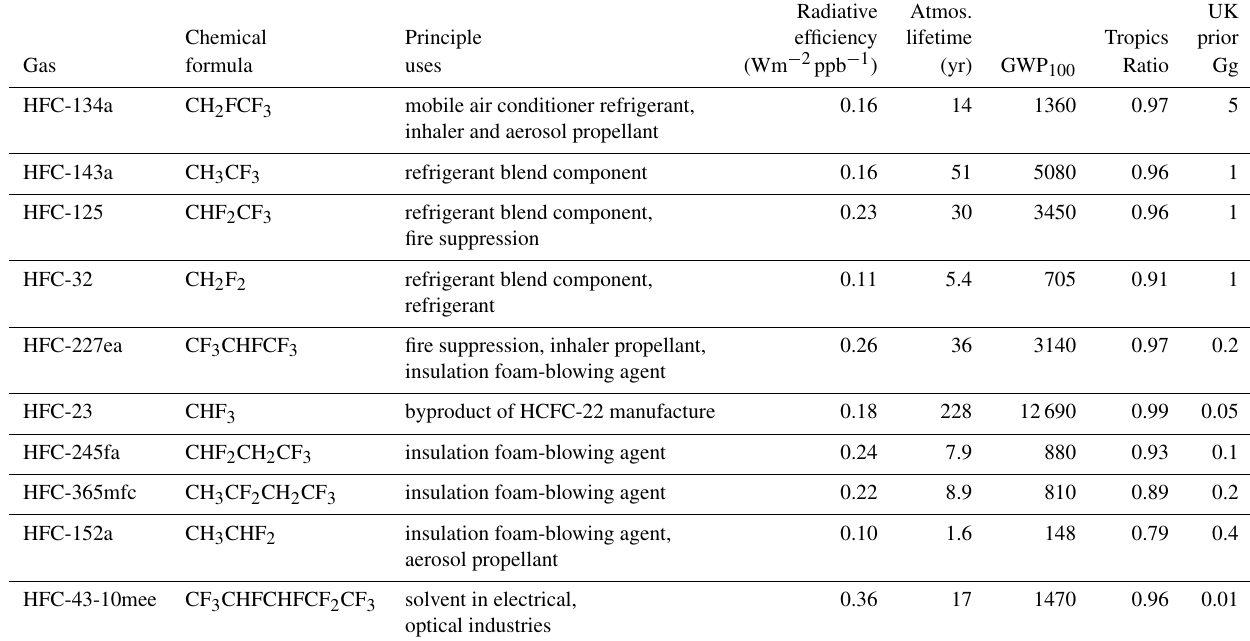
Table 4. Principle uses of each of the HFCs, their radiative efficiency, atmospheric lifetime, global warming potential in a 100-year framework (GWP 100 ) (Montzka et al., 2018b), average ratio of mole fraction between the northern tropics (RPB, Barbados) and the northern mid- latitudes (MHD, Ireland) and InTEM prior UK emissions. Radiative Atmos. UK Chemical Principle efficiency